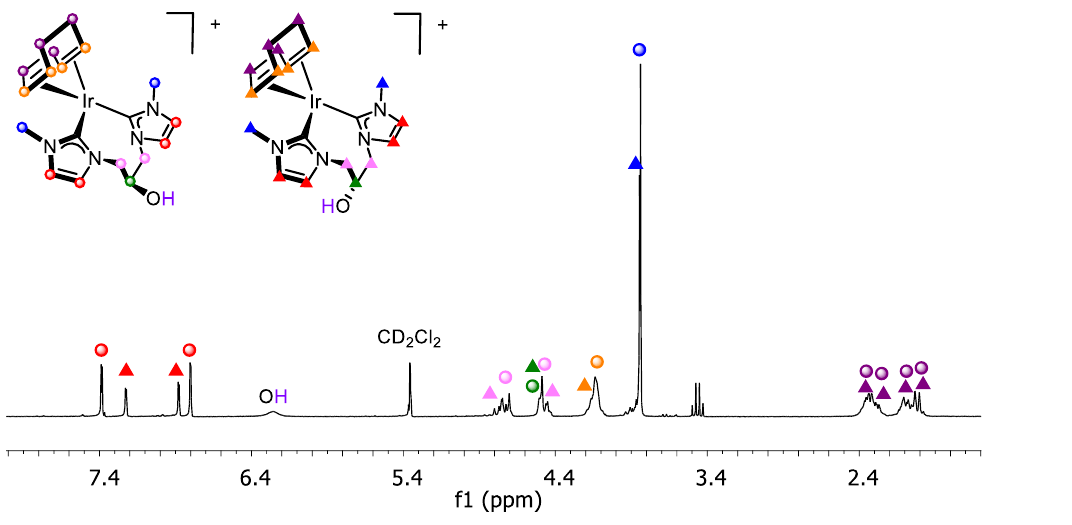
Figure 1. 1 H NMR (CD 2 Cl 2 , 298K) spectrum of [Ir(cod){(MeImCH 2 ) 2 CHOH}]Br ( 4 ) showing the presence of two isomers.